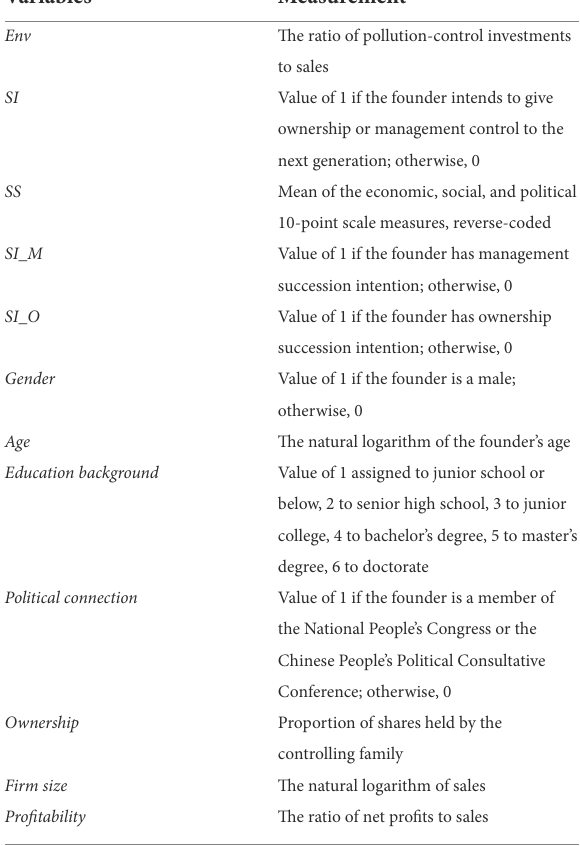
Variables Observations Mean Median Std.